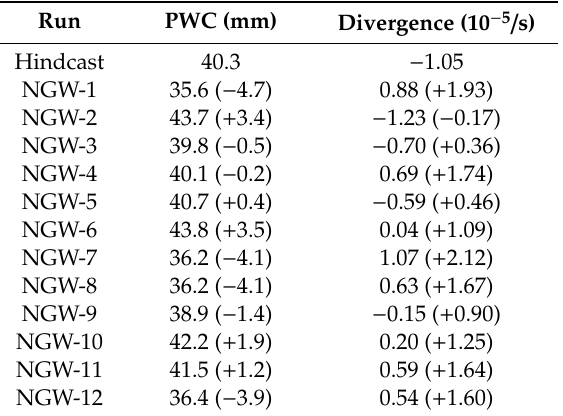
Table 9. Spatial mean PWC and divergence for area A at 18 UTC 9 September. Values in parentheses are the di ff erence between each NGW simulation and the hindcast. The result values are the ensemble mean for the hindcast and each NGW simulation.